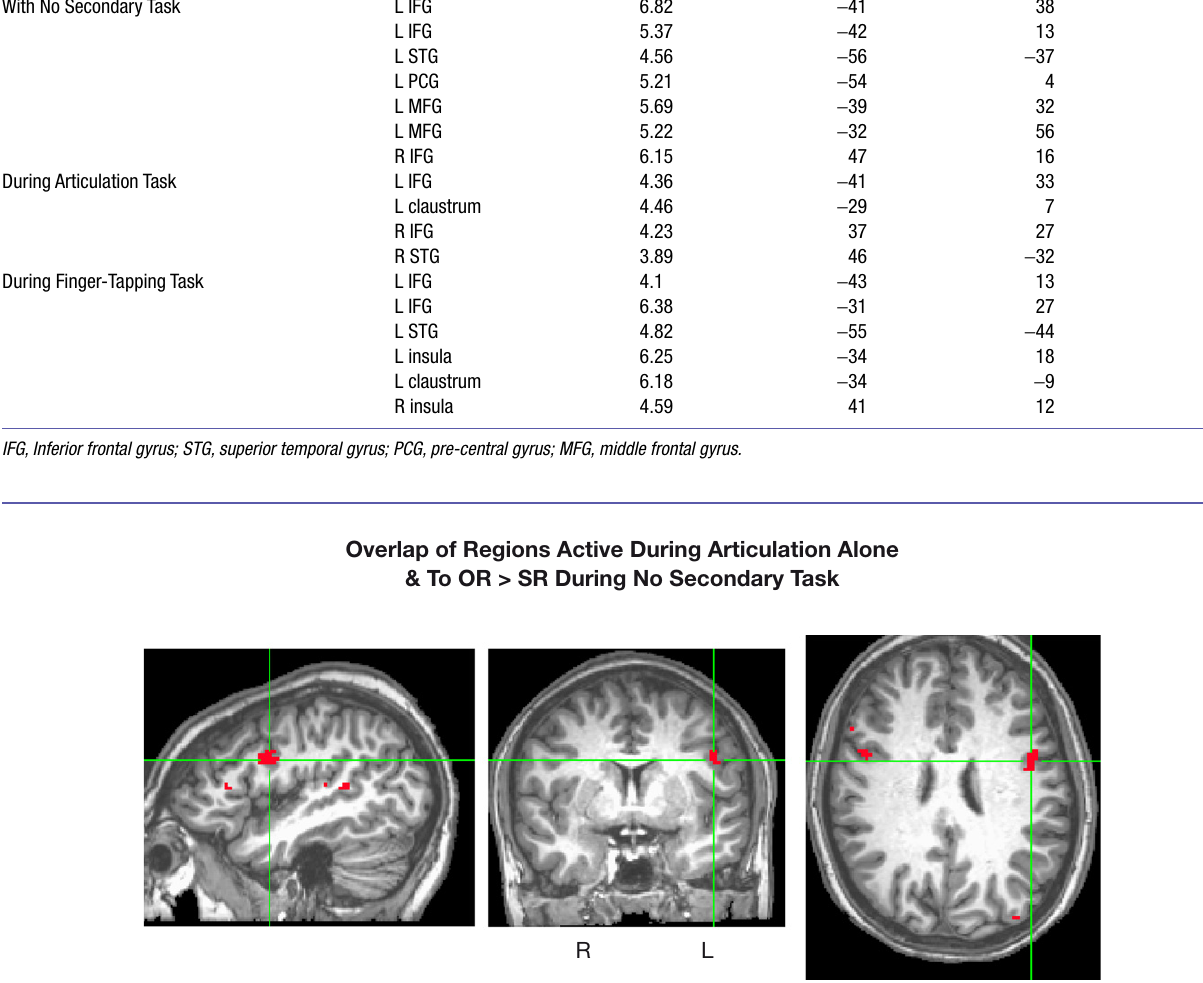
Table 4 | Peak t -test statistics/ p -values for the OR versus SR sentence contrast in each condition for the clusters in Broca’s area identifi ed as more active for OR than SR sentences in the absence of a concurrent